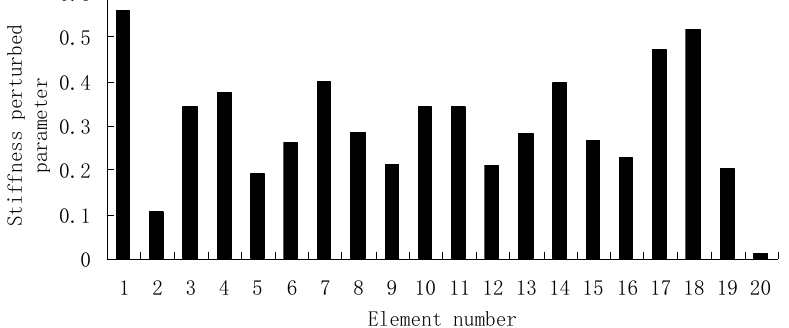
Figure 21. The stiffness perturbed parameters of the modified finite element model (FEM). Table 3. Comparisons of natural frequencies obtained by the original FEM, the modified FEM and the experiment.